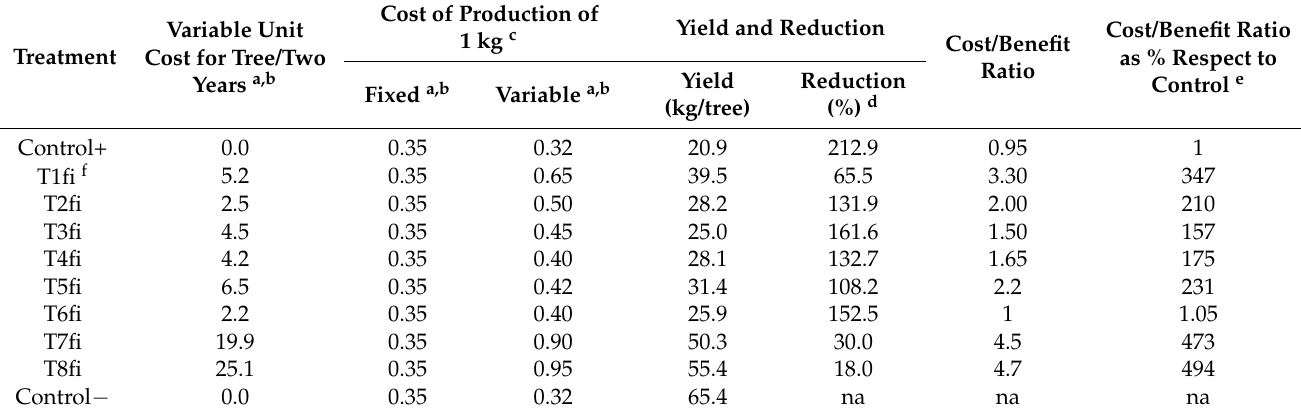
Table 1. Costs associated with Verticillium dahliae in avocado cv. Hass crops in Antioquia department, Colombia.